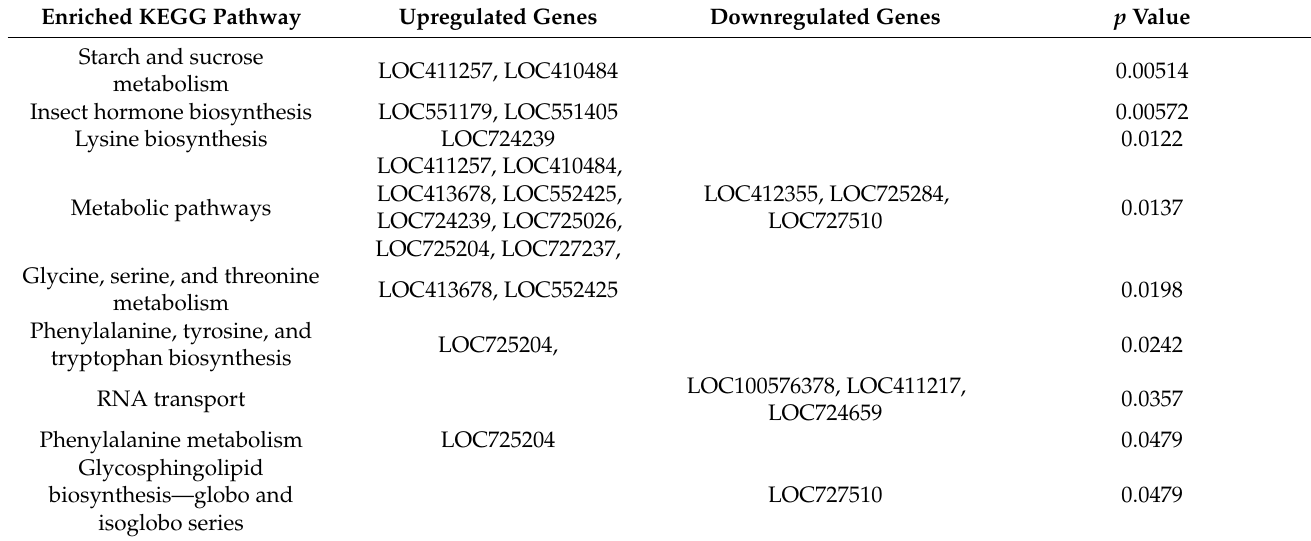
Table 2. Significantly enriched KEGG pathways related to upregulated and downregulated genes in the brains of cadmium-exposed